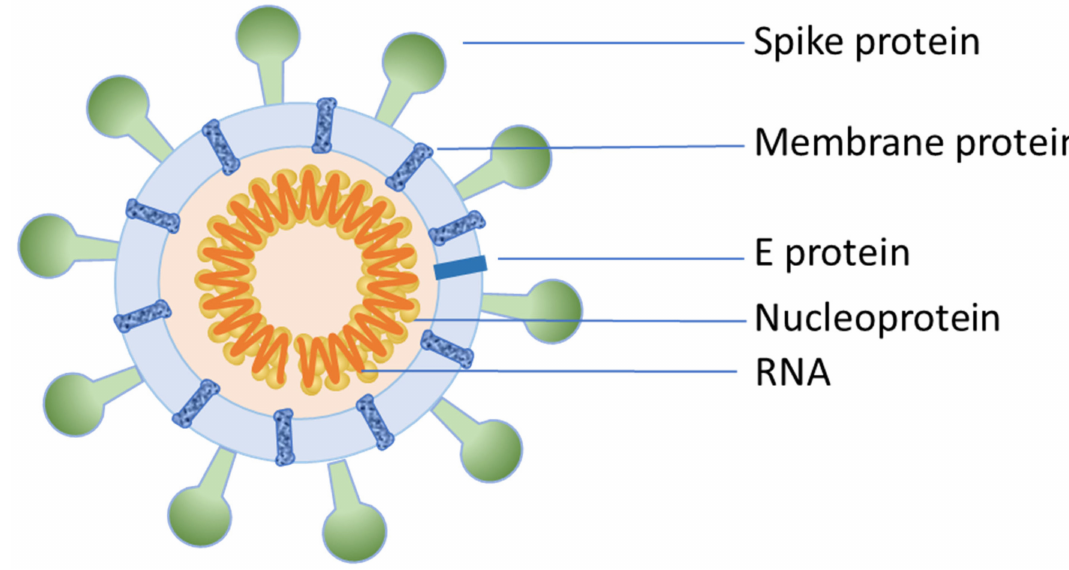
Figure 4. Typical scheme of severe acute respiratory syndrome coronavirus 2 (SARS-CoV-2) virion